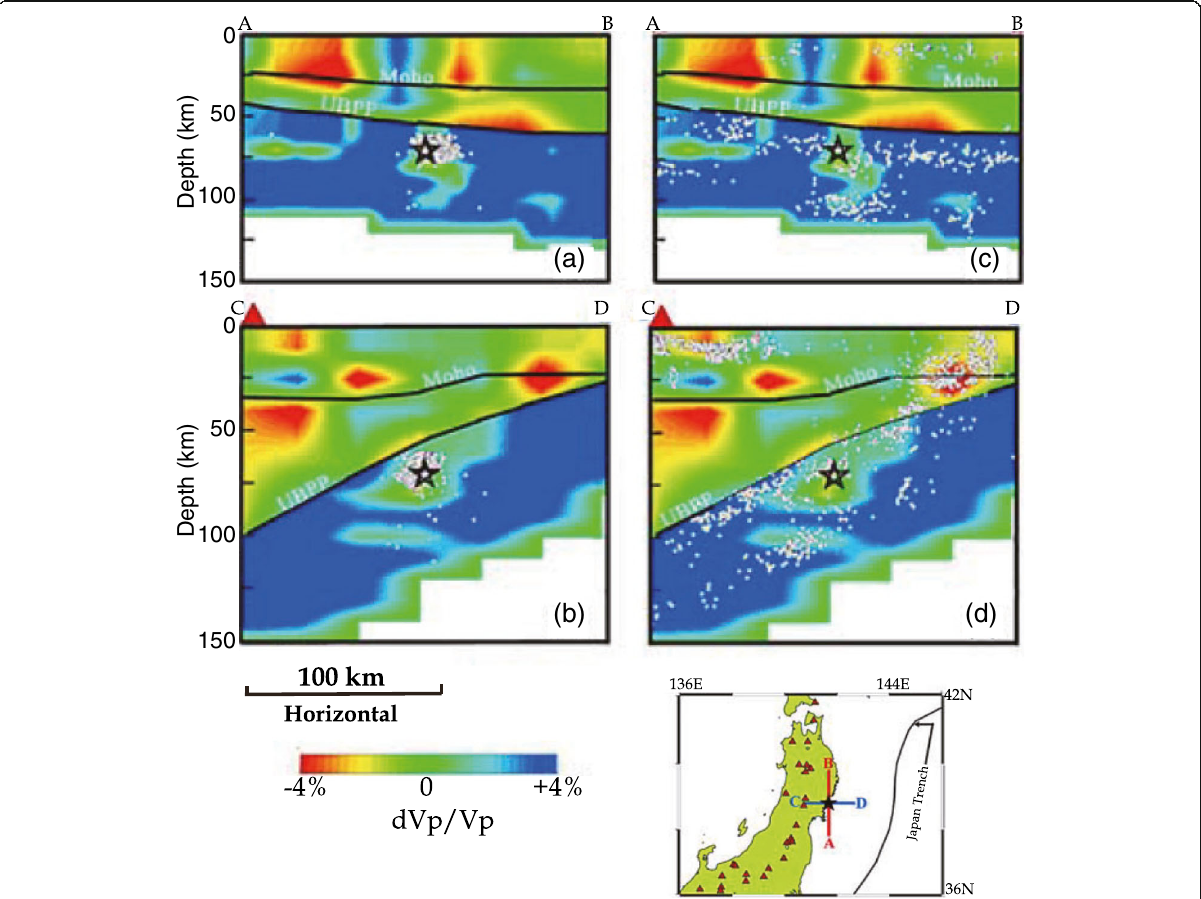
Fig. 17 P-wave velocity structure in and around the source area of the 2003 M 7.3 Miyagi – Oki intraslab earthquake. P-wave velocity perturbations are plotted based on the color scale at the bottom for a , c N – S and b , d E – W vertical cross-sections along lines shown in the inset map. White dots in a and b are aftershocks of the M 7.3 event, and those in c and d are background seismicity. Hypocenter of the M 7.3 event is indicated by a star. Thick curves are the Moho of the upper plate and the top surface of the subducting Pacific slab, in order from the top . (After Mishra and Zhao,